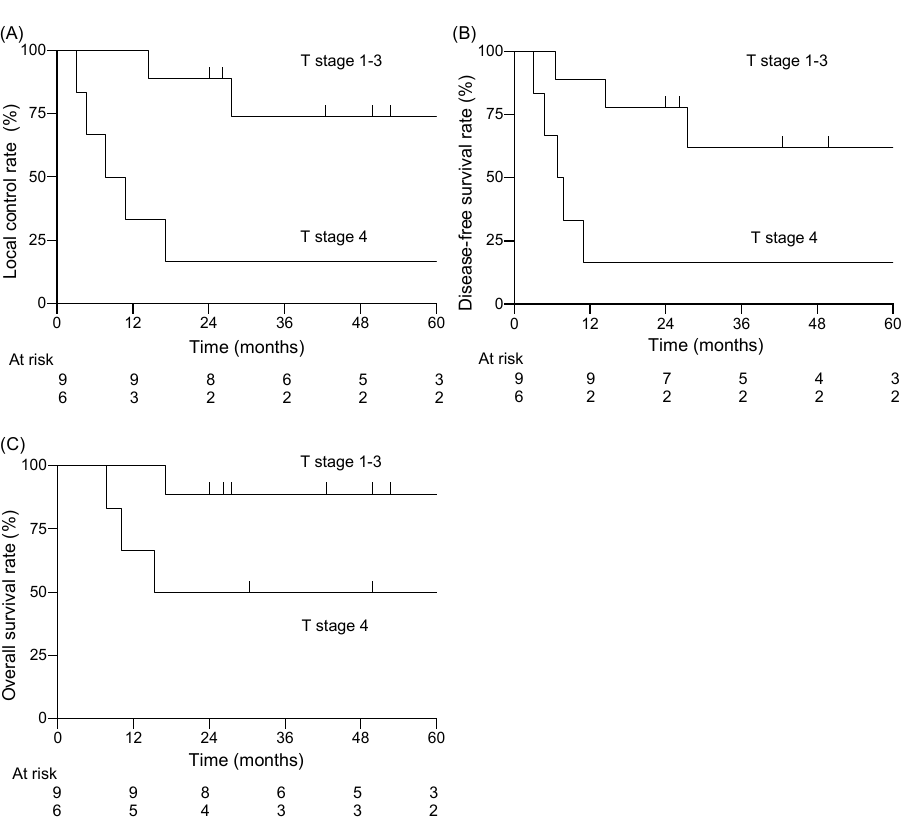
Figure 3. Kaplan–Meier curves stratified by T-category; T1–3 vs. T4 for ( A ) local control rate, ( B ) disease-free survival rate, ( C ) overall survival rate.